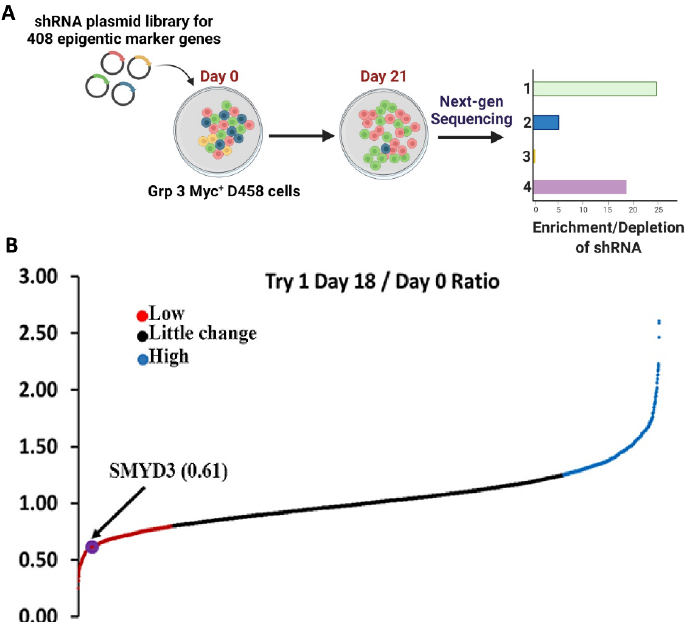
Figure 1. Functional genome-wide screening to identify novel epigenetic regulators in MB. ( A ) Schematics of the RNAi-based function genomic screen. In collaboration with Dr. Vibhakar’s lab [11], Pooled shRNAs targeting 408 genes (4–10 shRNAs per gene) involved in epigenetic regulation were transduced into D458 cells and analyzed for loss of function. Genomic DNA was isolated at 4 and 21 days after transduction, processed, and sequenced with an Illumina HiSeq instrument. The sequencing data compared the shRNAs on day 4 to day 21, with false discovery rates (FDRs) of 0.5 and 0.1, respectively. Underrepresented shRNAs are genes required for MB growth. ( B ) Aggregate normalized sequencing data showing depleted shRNAs (blue), unchanged shRNAs (red), and enriched shRNAs (green) at 21 days after transduction. The arrow shows the depletion of shRNA corresponding to SMYD3.